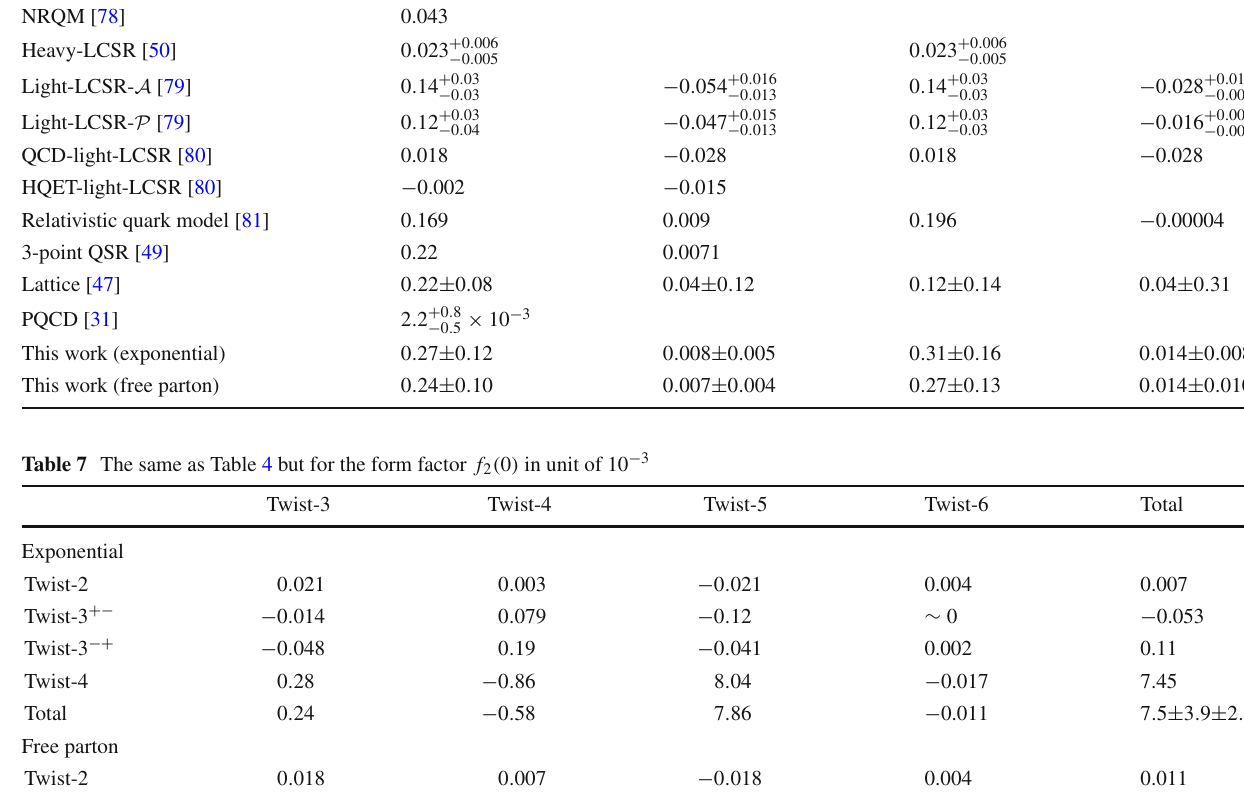
PQCD studies. The theoretical errors of our results from the variations of the relevant parameters in the (cid:2) b baryon and proton LCDAs have